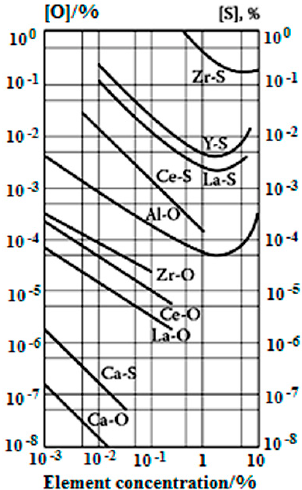
Figure 7. Equilibrium curves showing the affinity of a few alloying elements to oxygen and sulfur in iron at 1600 °C, reproduced from Reference [33], with permission of Springer, 2016.